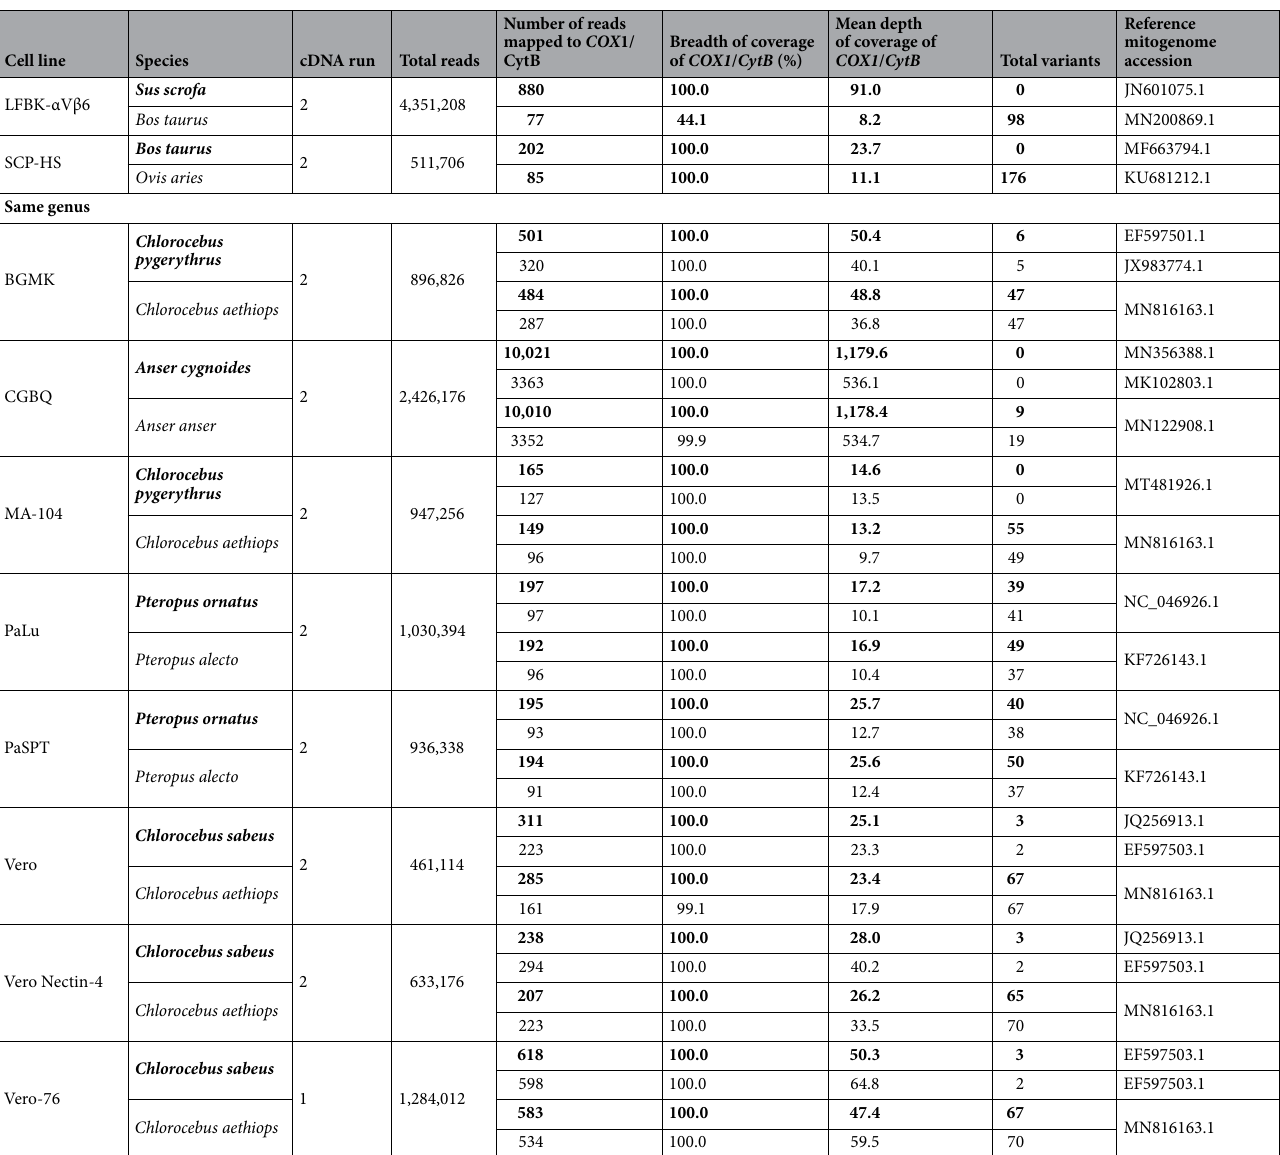
Table 2. Cell lines in which a different species from institution records was identified. Species names in bold are the observed species while the non-bolded names are the expected species based on laboratory records. Bold values indicate results to COX1 reference while non-bolded cells are to CytB reference. Variants were only called if the read depth had a minimum coverage of 3×. Threshold for coverage depth for calling breadth and depth of coverage was set to 3, while the minimum variant frequency =